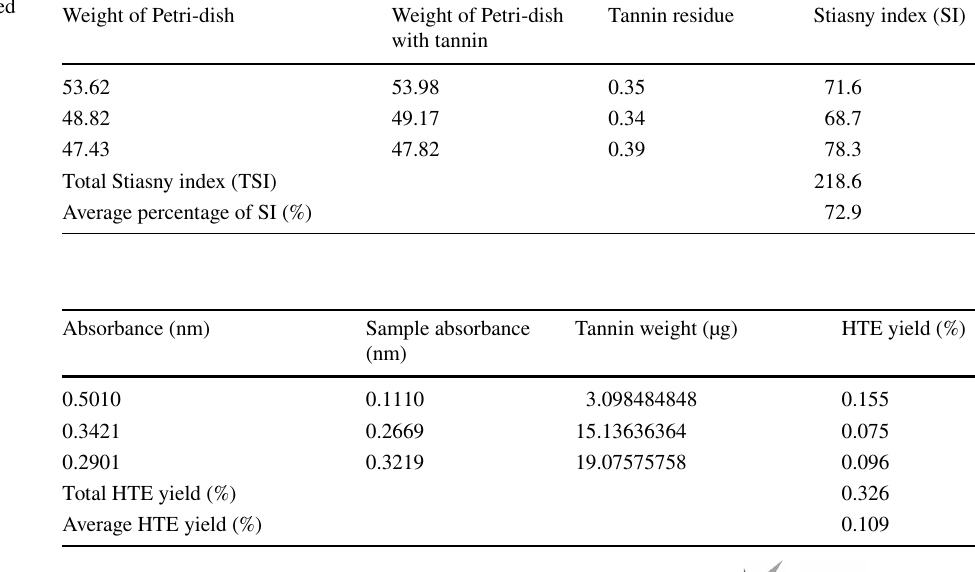
Table 3 The data for condensed tannin extracts (CTE)